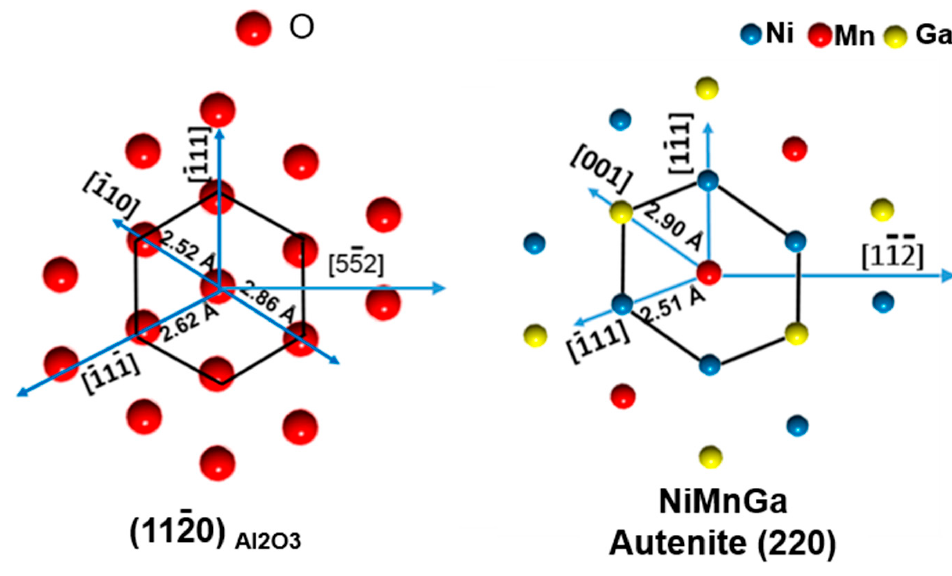
Figure 6. The mismatched relationship between the Al 2 O 3 substrate and the Austenite of Ni-Mn-Ga.